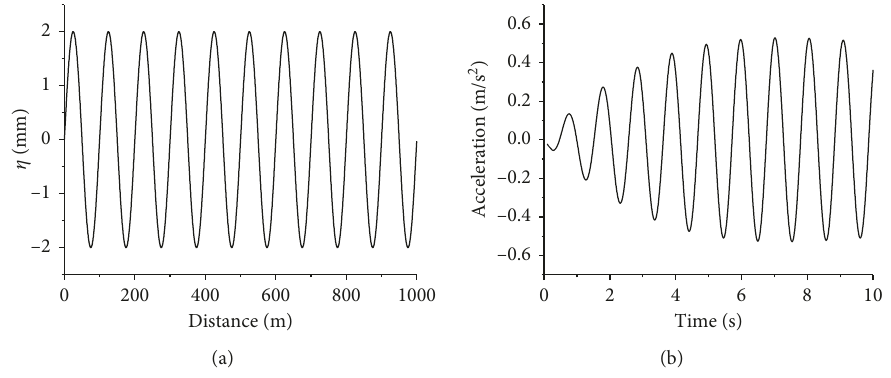
Figure 9: Simulation input and output. (a) Sinusoidal longitudinal-level irregularity. (b) Simulation result.